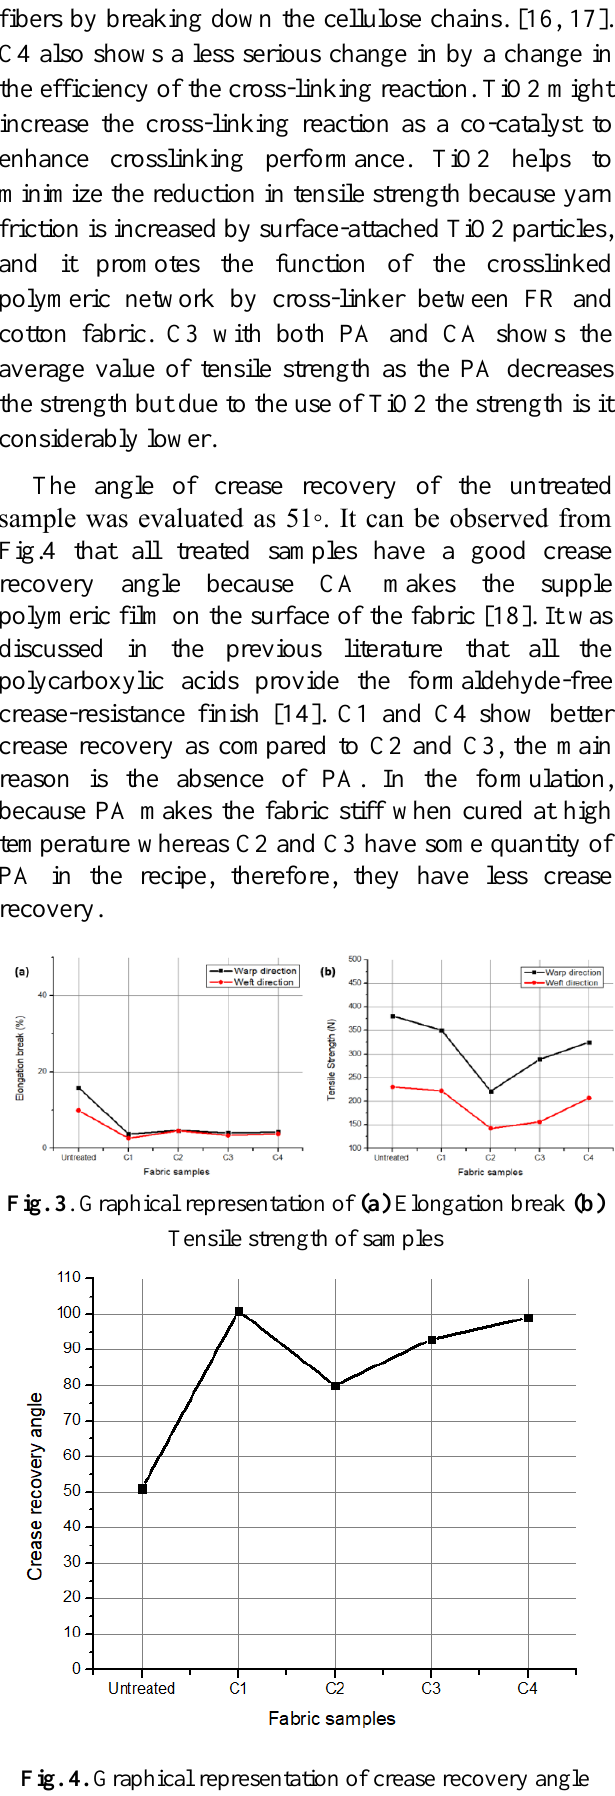
Fig. 4. Graphical representation of crease recovery